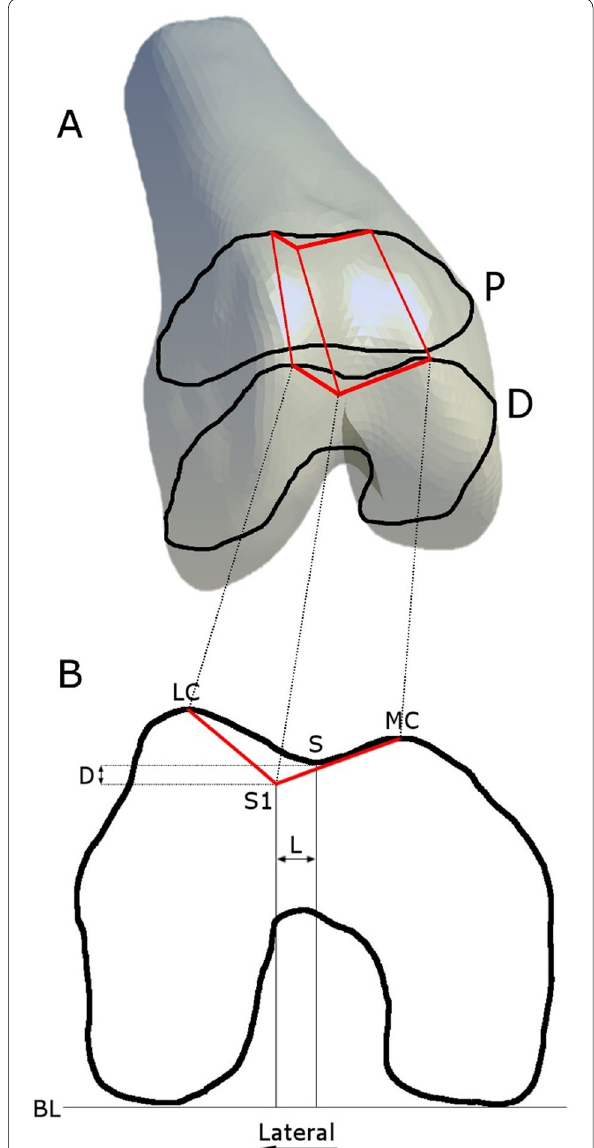
Fig. 1 A Anterior view of the distal femur. Superimposed are the proximal (P) and the distal (D) schematic measurement planes used to virtually osteotomize the femur. The proximal plane is defined by the axial MR image, when the trochlea is initially completely covered with cartilage. The distal plane is defined by the axial MR image before the trochlear groove curves into the femoral notch. The wedge containing the osteotomized bone is depicted in red. B Schematic axial slice of the distal femur showing the virtual osteotomy conducted. The sulcus (S) is lateralized (L) and deepened (D) according to the reported results by Fucentese et al. [16], oriented parallel and perpendicular to the baseline (BL) respectively. The bone anterior to the line (depicted in red) connecting the most prominent lateral condylar point (LC), the newly defined sulcus (S1) and the most prominent medial condylar point (MC) is